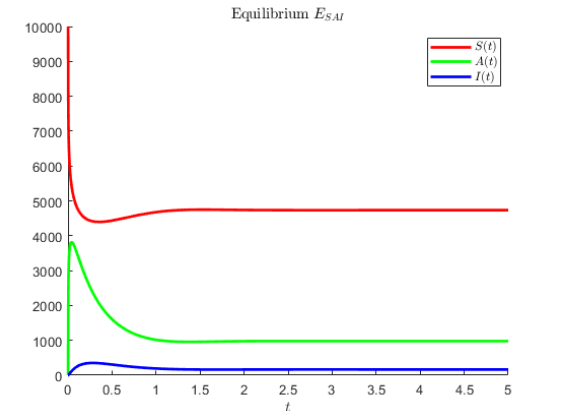
Figure 3. Coexistence equilibrium for model (1) obtained with parameter values (54), (51) and initial conditions (50).